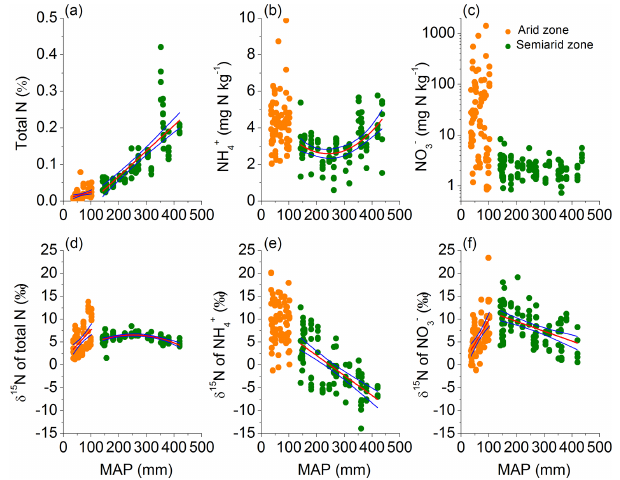
Figure 2. Nitrogen concentrations and isotopic composition of bulk soil N, NH + , and NO − . The significant ( P< 0 . 05) trends are shown 4 3 with a regression line (red) and 95% confidence intervals (blue). At each site n = 5.